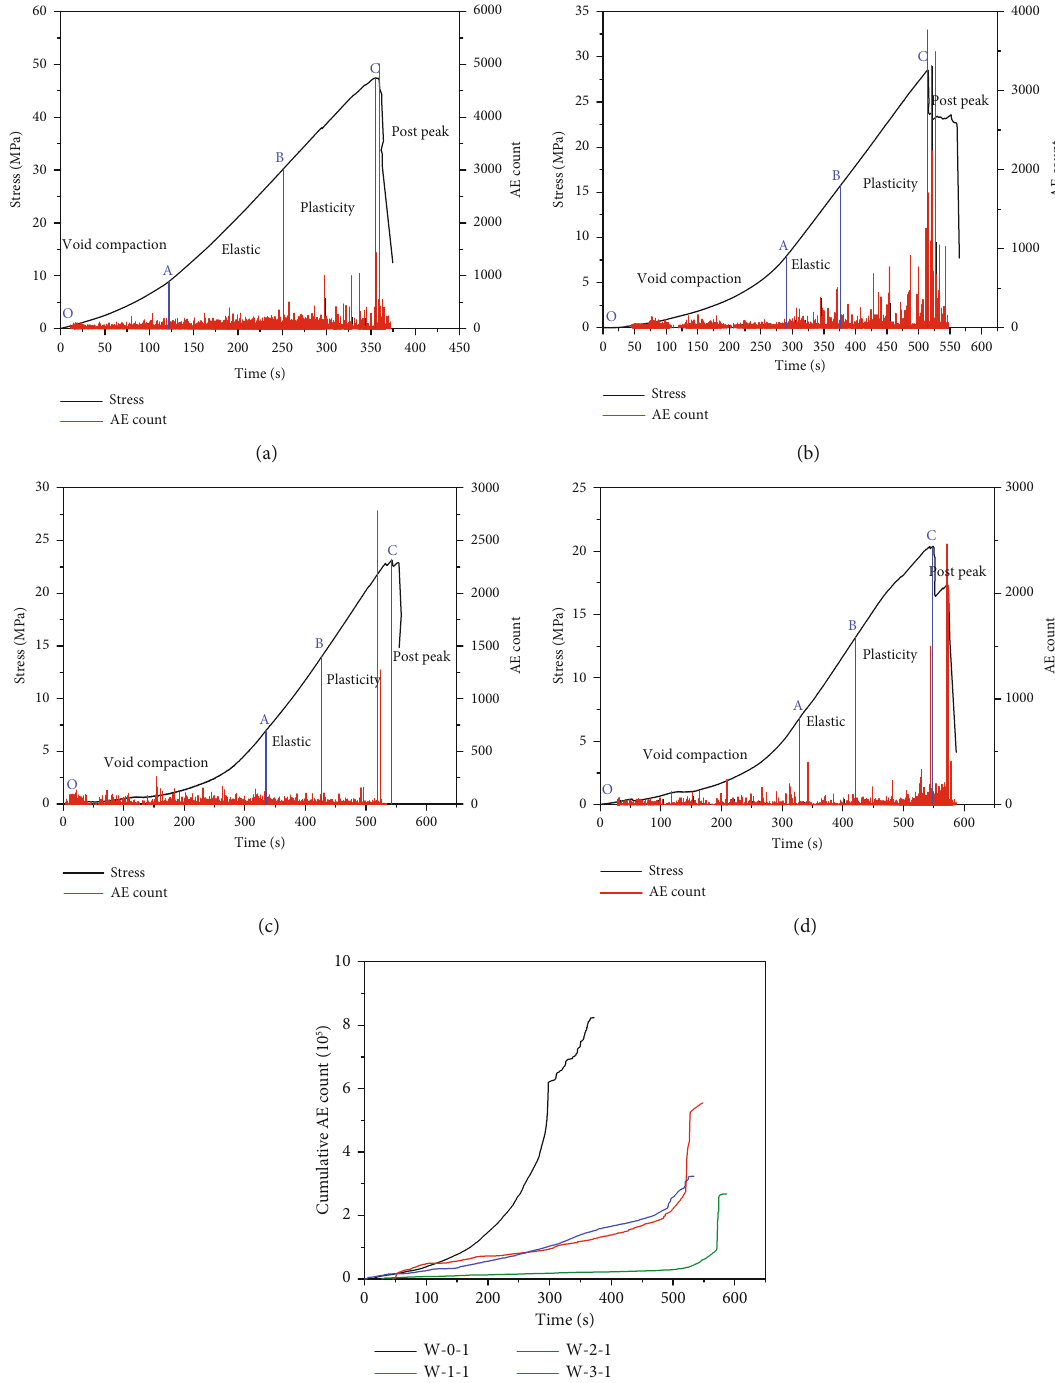
Figure 10: Corresponding relationship between AE count, cumulative AE, and stress of rock samples with di ff erent moisture content. (a) Stress AE count time curve of W0-1, (b) stress AE count time curve of W1-1, (c) stress AE count time curve of W2-1, (d) stress AE count time curve of W3-1, and (e) cumulative AE count time